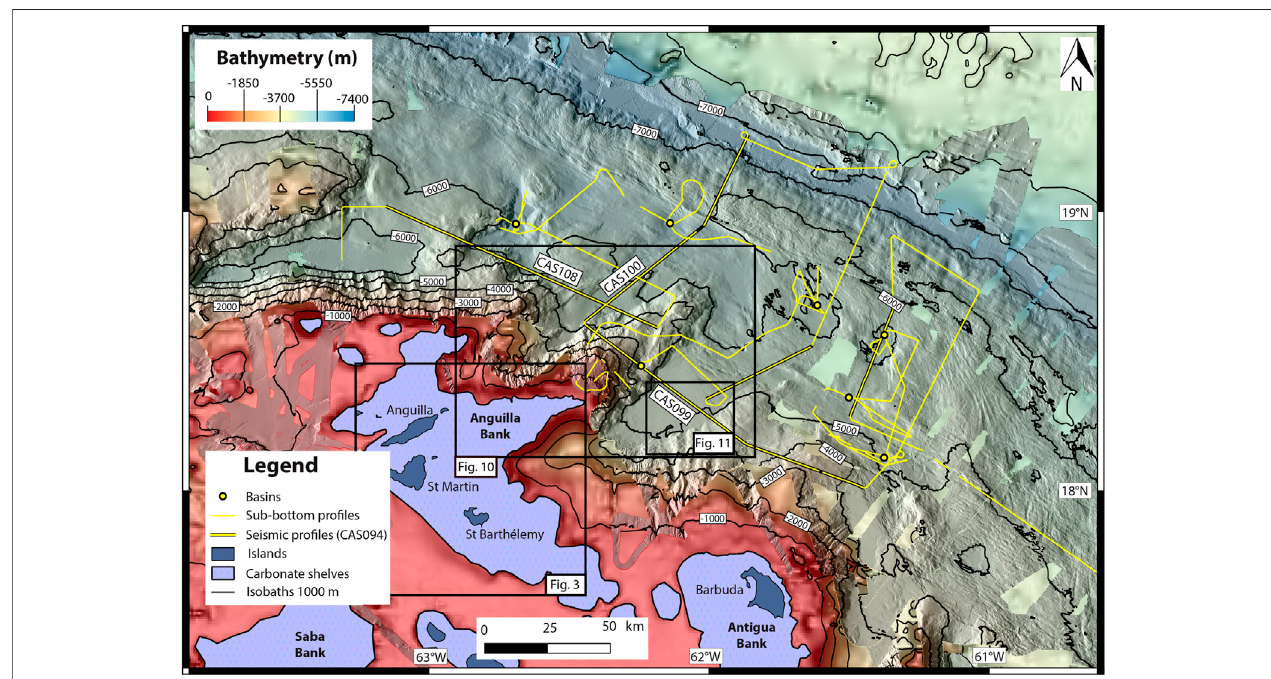
FIGURE 2 | Data from ANTITHESIS (2013 – 2016) and CASEIS (2016) cruises in the NLAS. Black lines represent the seismic pro fi les: CAS108 ( Figures 7A , 10 ), CAS099 ( Figure 7B ), and CAS100 ( Figure 10 ). Black boxes locate Figures 3 , 10 , 12 .